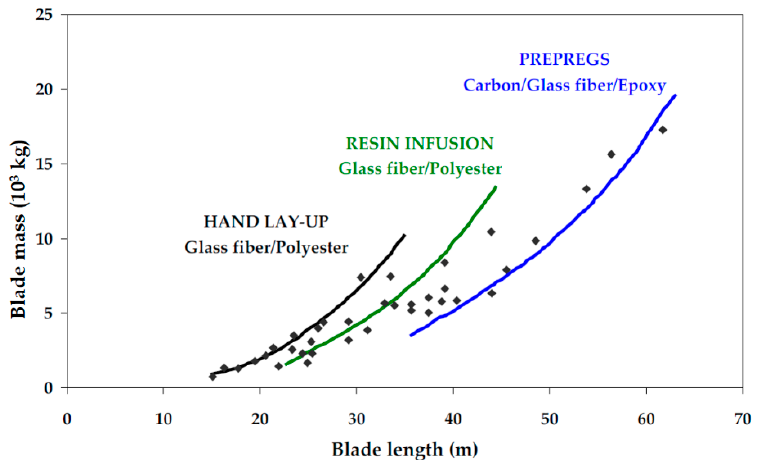
Figure 1. Manufacturing process and materials used in terms of blade mass and blade length [17].